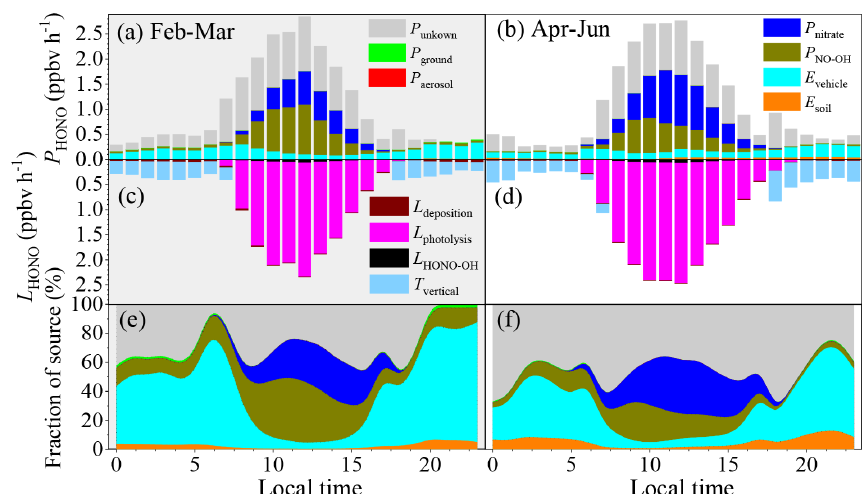
Figure 4. The HONO budget. (a, b) Diurnal production rates of HONO; (c, d) loss rates of HONO; (e, f) relative contributions of each source on polluted days with PM 2 . 5 concentrations of greater than 50µgm − 3 and RH values of less than 90%. Panels (a) , (c) , and (e) show the data from 1 February to 31 March, and panels (b) , (d) , and (f) show the data from 1 April to 30 June.